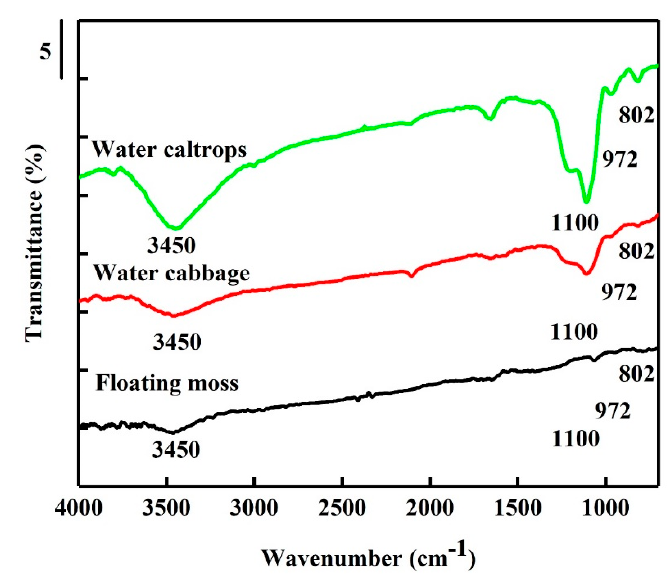
Figure 4. Fourier transform infrared (FTIR) spectra of the silicon oxycarbide (SiOC) samples.